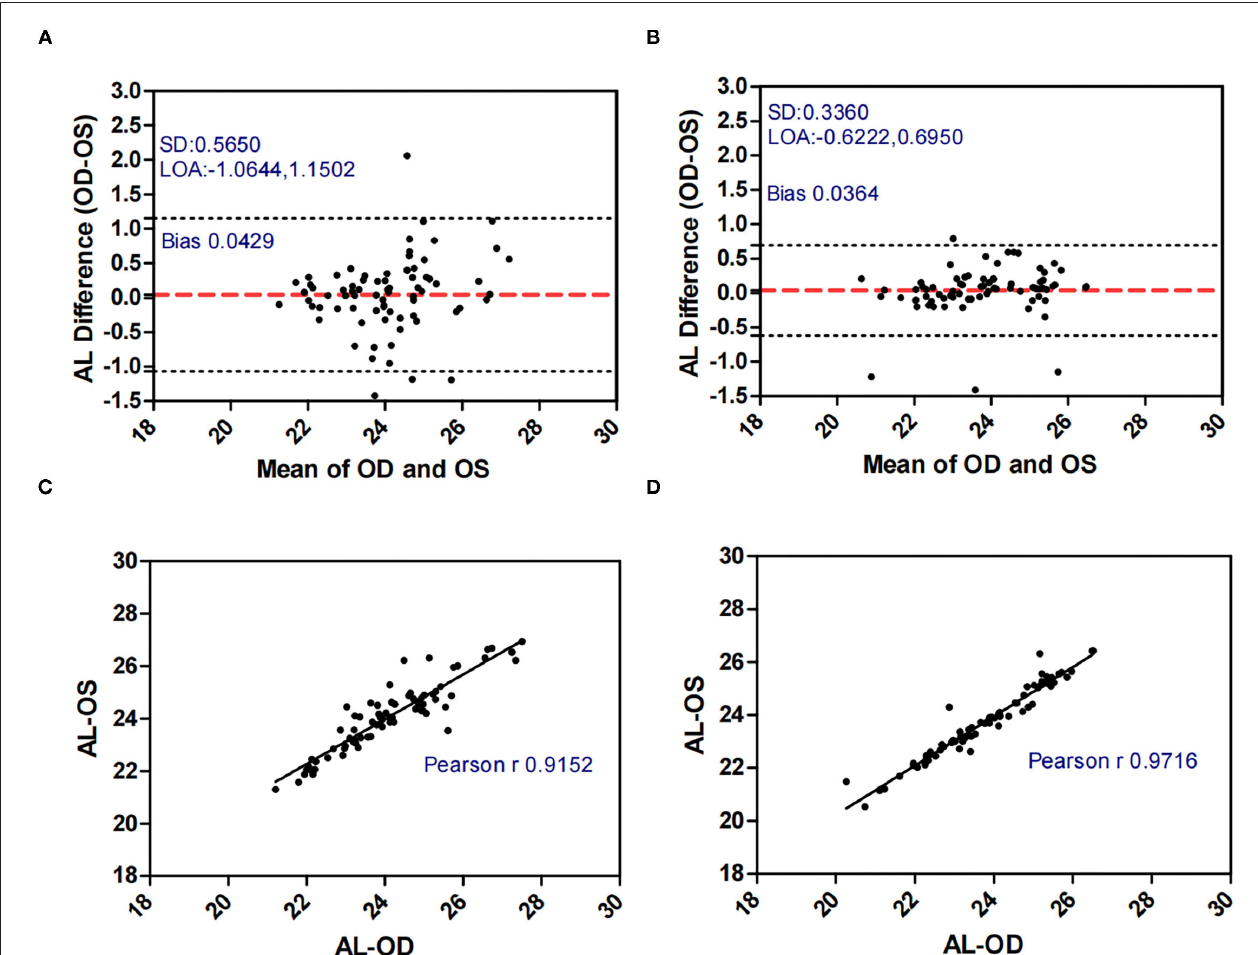
FIGURE 2 | Bland-Altman plots (A,B) and scatter plots (C,D) of AL in concomitant exotropia (A,C) and normal control participants (B,D) of the left and right eyes. OS, left eye; OD, right eye; AL, axial length; LOA, 95% limits of